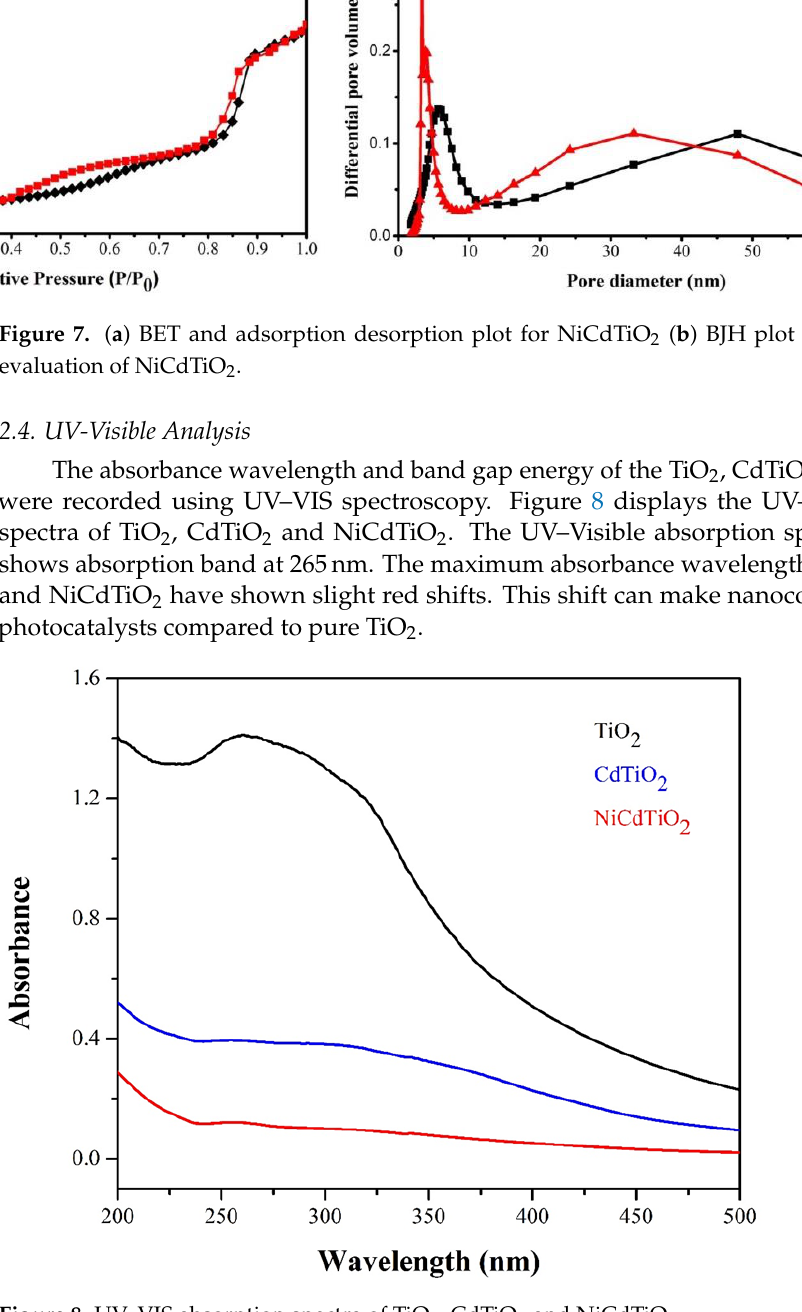
2 , CdTiO 2 and NiCdTiO 2